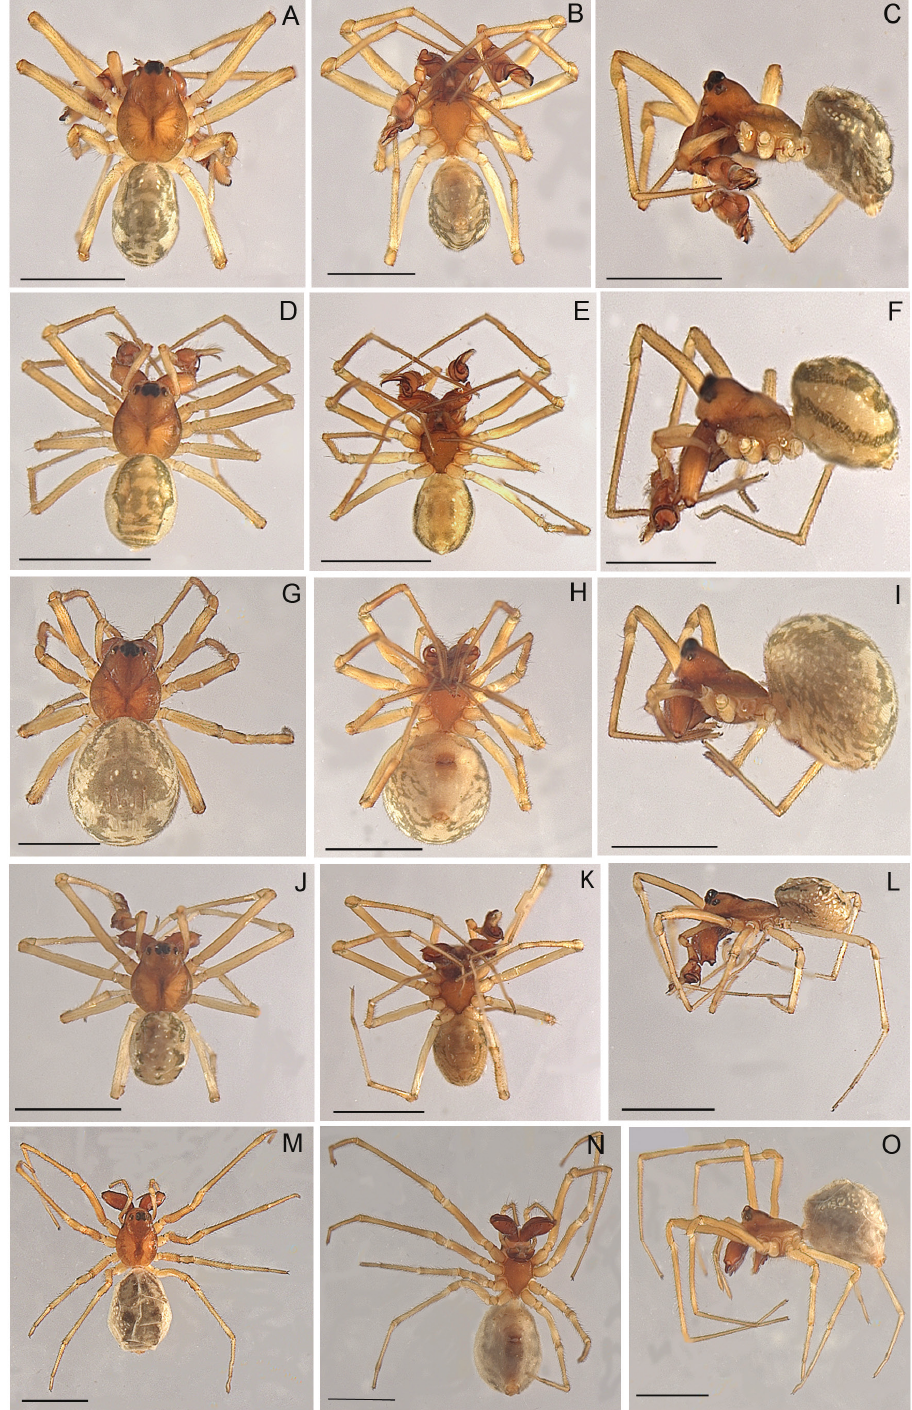
Fig. 1. A–C . Pachygnatha bispiralis sp. nov. A . Male habitus, dorsal view. B . Male habitus, ventral view. C . Male habitus, lateral view. D–I . Pachygnatha intermedia sp. nov. D . Male habitus, dorsal view. E . Male habitus, ventral view. F . Male habitus, lateral view. G . Female habitus, dorsal view. H . Female habitus, ventral view. I . Female habitus, lateral view. J–O . Pachygnatha ventricosa sp. nov. J . Male habitus, dorsal view. K . Male habitus, ventral view. L . Male habitus, lateral view. M . Female habitus, dorsal view. N . Female habitus, ventral view. O . Female habitus, lateral view. Scale bars = 2